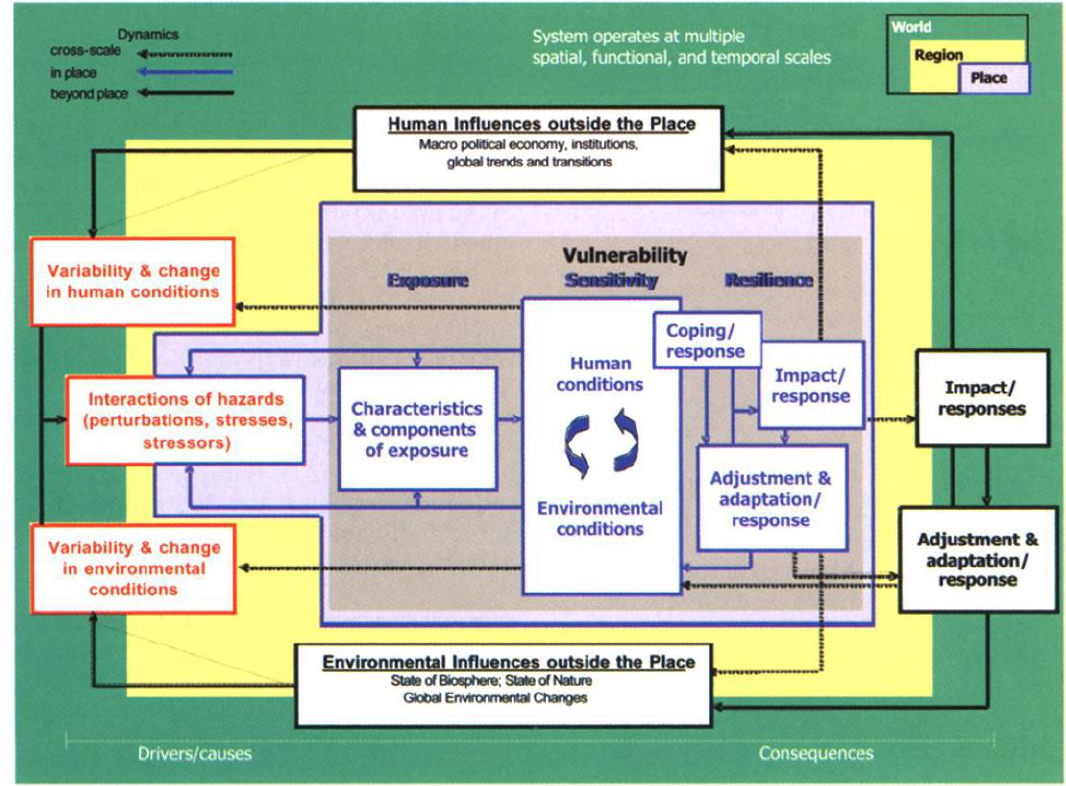
Figure A2.4. Vulnerability Framework